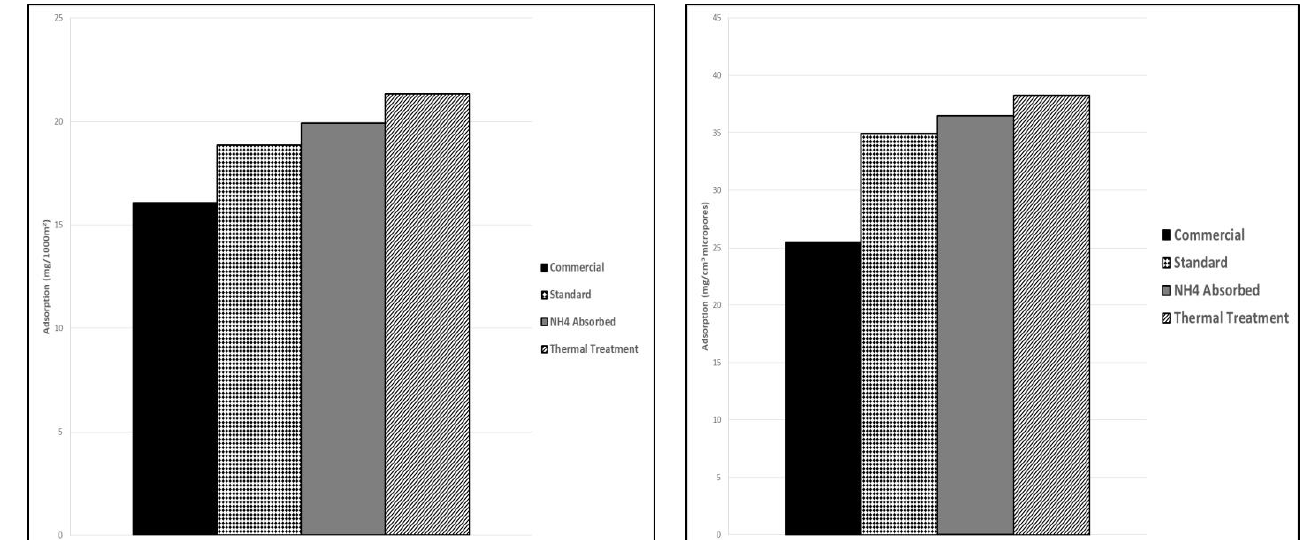
Figure 3. ( Left ) Adsorption capacity of chromium (VI) for activated carbons normalized to 1000 m 2 surface area. ( Right ) Adsorption capacity of chromium (VI) for activated carbons normalized to 1 cm 3 pore volume and adjusted for microporosity percentage.